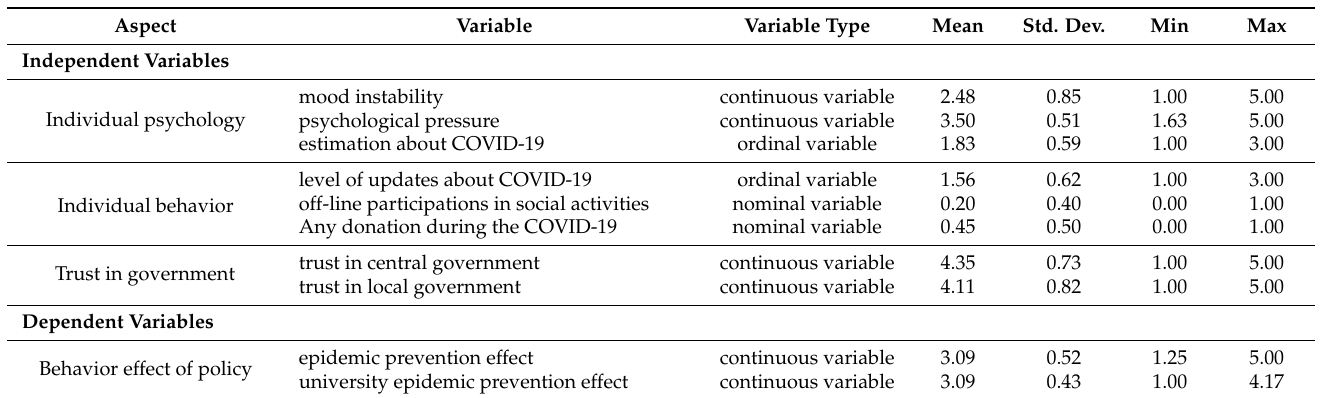
Table 3. Descriptive statistics of the